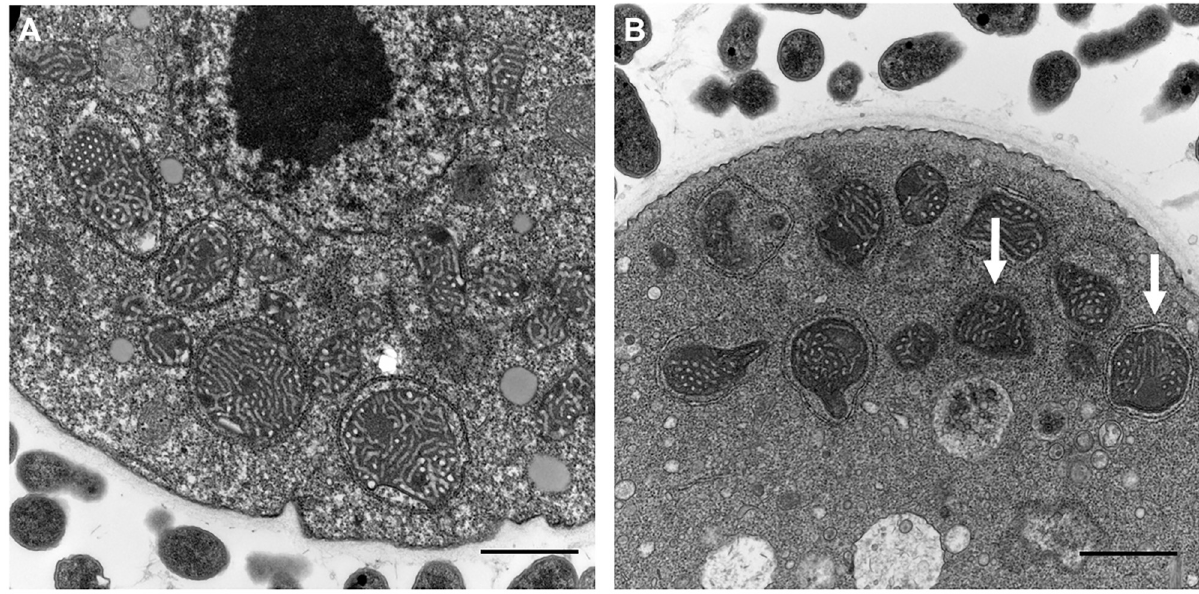
Fig 4. Mitochondrial morphologic changes in A . lugdunensis . After treatment with 50 μ g/mL (B) of T . nucifera , structural damage and decreased wrinkling was observed compared with that in the control group (A). The scale bar represents 1 μ m.